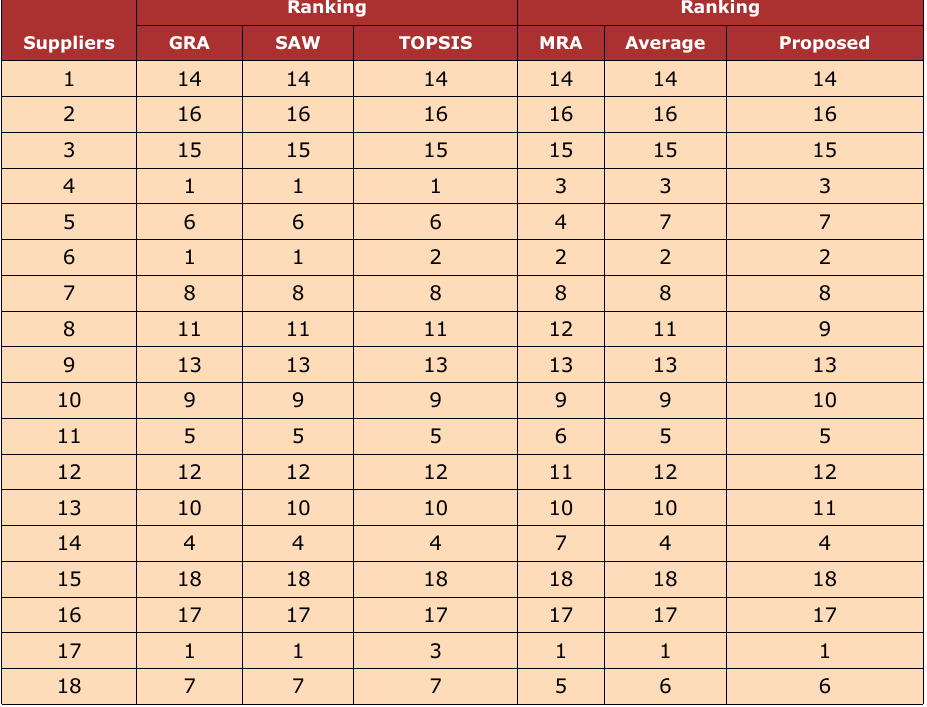
Table 11. Comparing the obtained